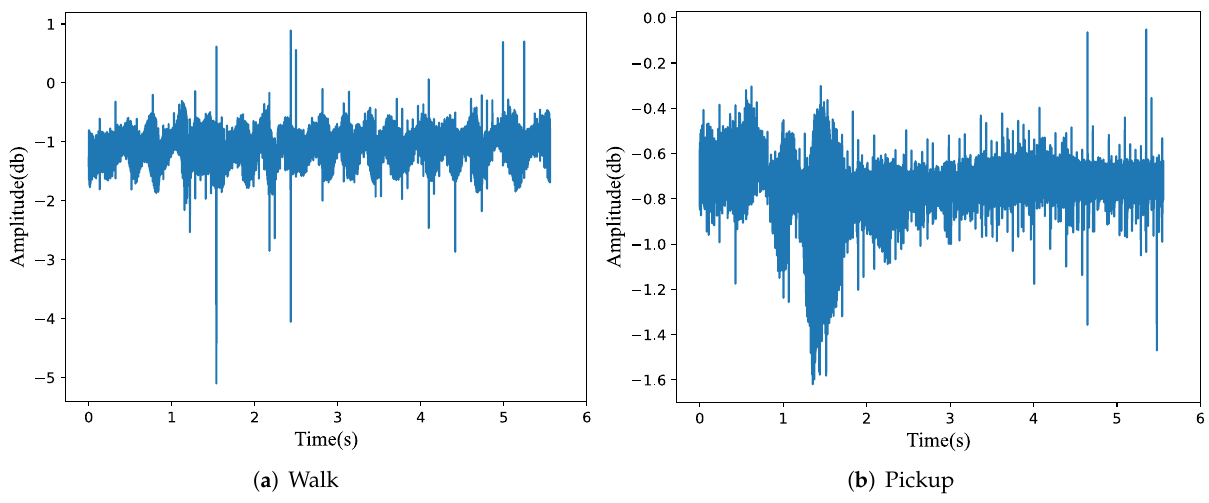
Figure 1. Amplitude of walk and pickup